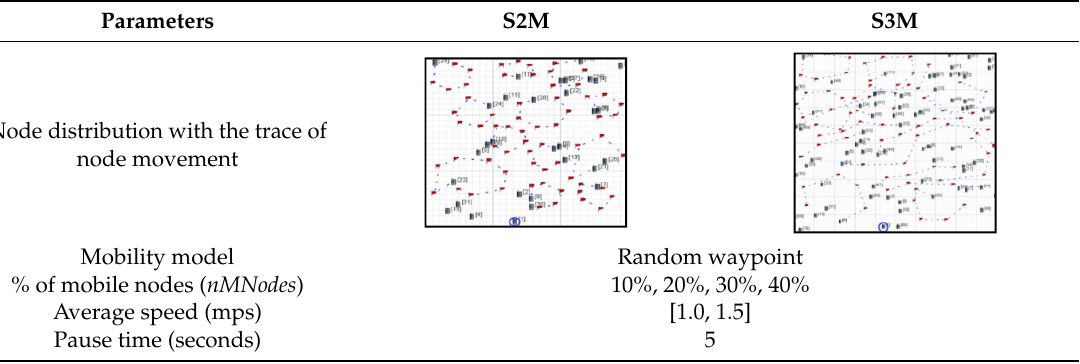
Table 5. Two dynamic network scenarios corresponding to S2 and S3 in Table 4.